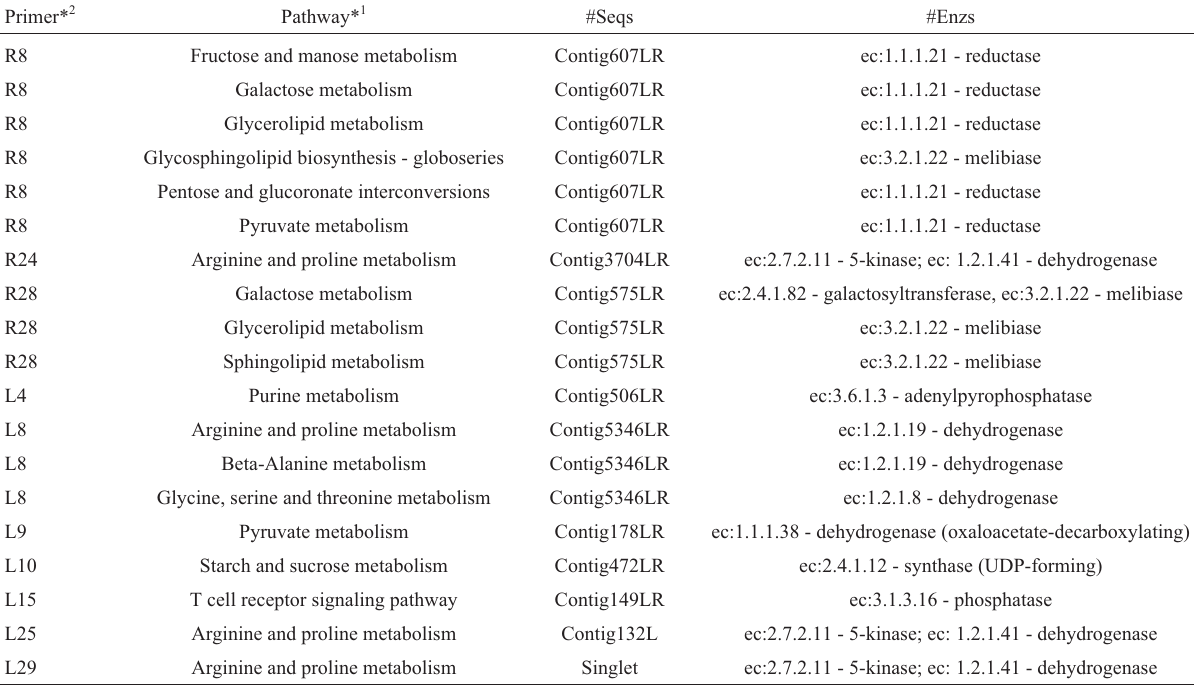
Table 2 - Biological pathways related to 10 sequences validated by RT-qPCR and the respective contigs where they assemble in CAP3. Primer*